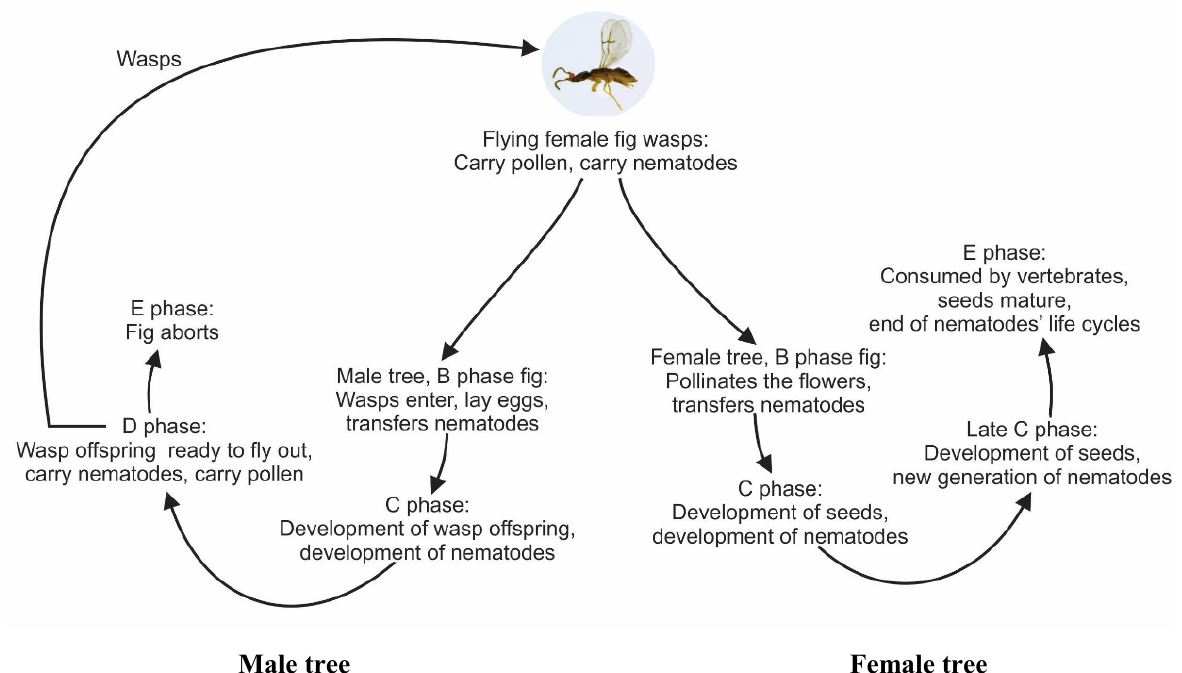
Figure 5. Summary of the life cycles of fig nematodes and pollinator fig wasps associated with male and female Ficus hispida .